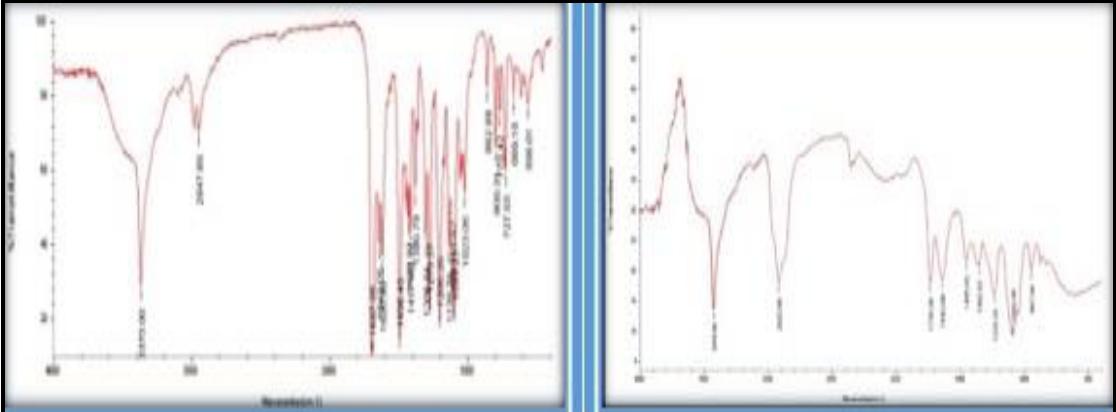
Figure 8. The FTIR spectrum of pure felodipine Figure 9 .FTIR spectrum of the selected formula